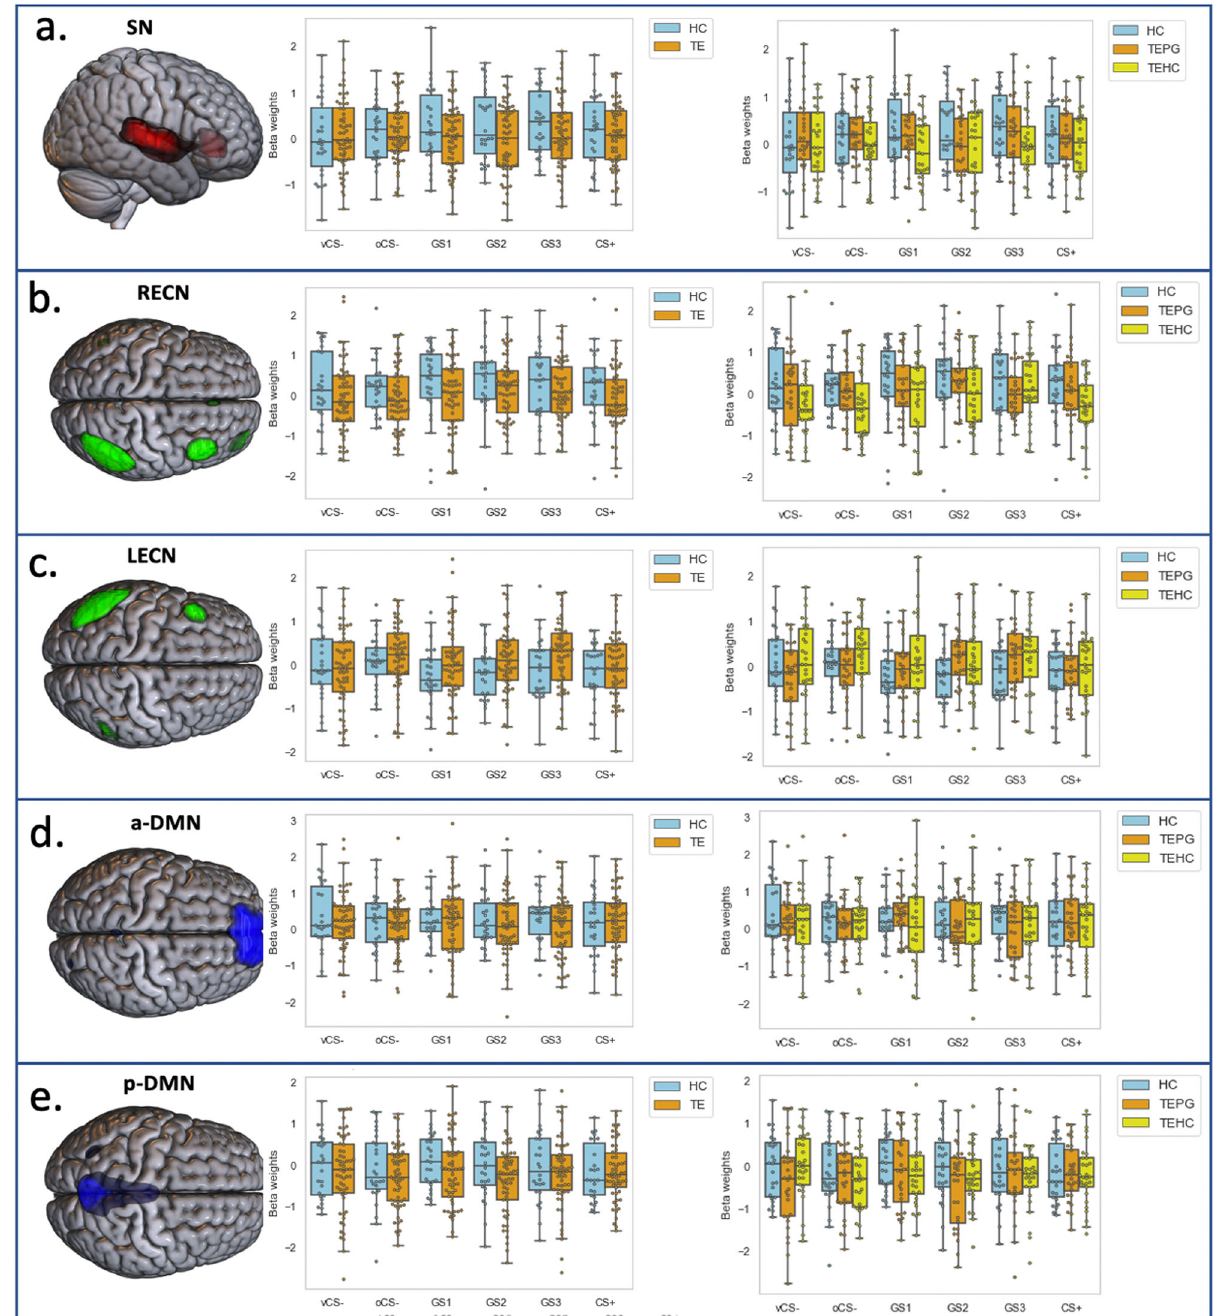
phases to conditioned and generalization stimuli (vCS-, oCS-, GS1, GS2, GS3, CS + ) for ( a ) salience network (SN); ( b ) right executive control network (RECN); ( c ) left executive control network (LECN); ( d ) anterior default mode network (a-DMN); and e ) posterior default mode network (p-DMN) across two stages, n = 88, error bar stand for ±2 standard error (SE). CS + conditioned stimuli, danger cue, oCS- conditioned stimuli, o shape safe cue, vCS- conditioned stimuli, v shape safe cue, GS generalization stimuli, HC non-trauma-exposed healthy controls, TEHC trauma-exposed healthy controls, TEPG trauma-exposed psychopathology